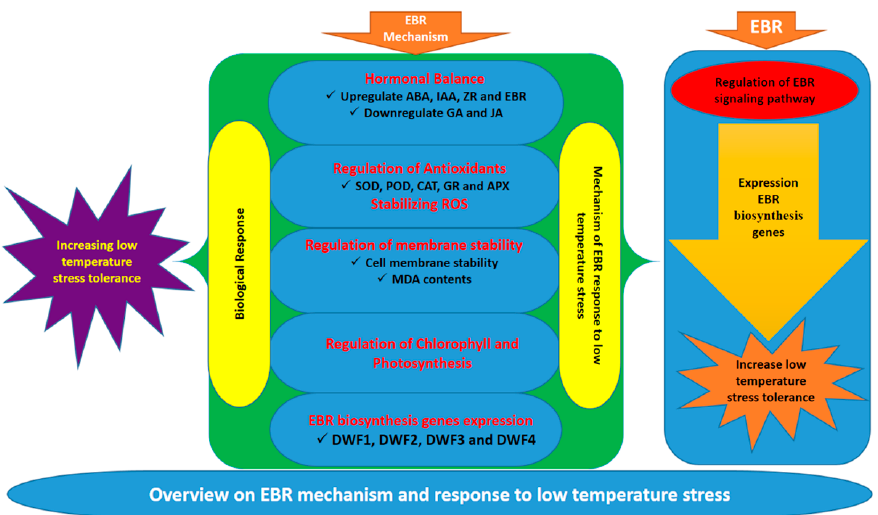
Figure 6. A proposed model for induction of low-temperature stress tolerance by EBR in cucumber seedlings.